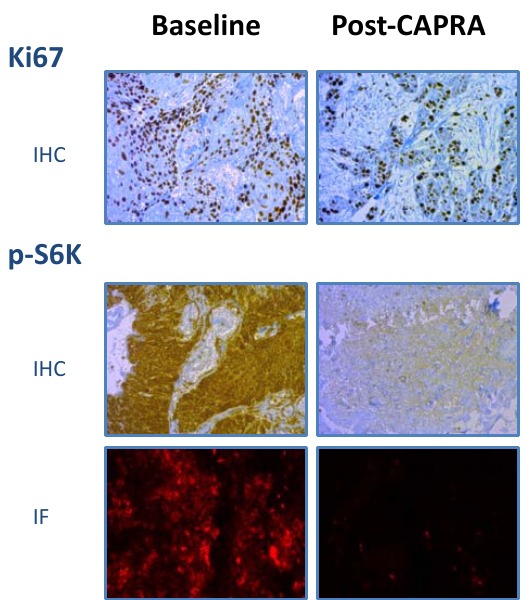
Figure 5. Pharmacodynamic histological biomarkers: representative staining of Ki67 immunohisto- chemistry and p-S6K immunohistochemistry and immunofluorescence at baseline and after 9 cycles of induction treatment (N = 9). IF: immunofluorescence, IHC: immunohistochemistry.